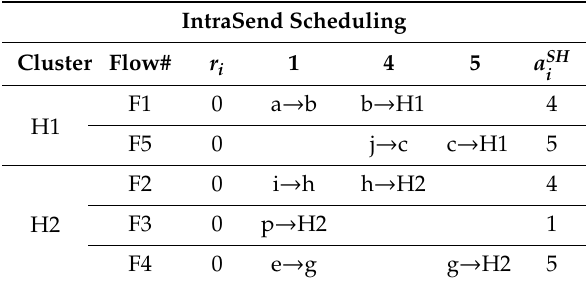
Table 4. Results of proposed scheme IntraSend scheduling of Figure 2.